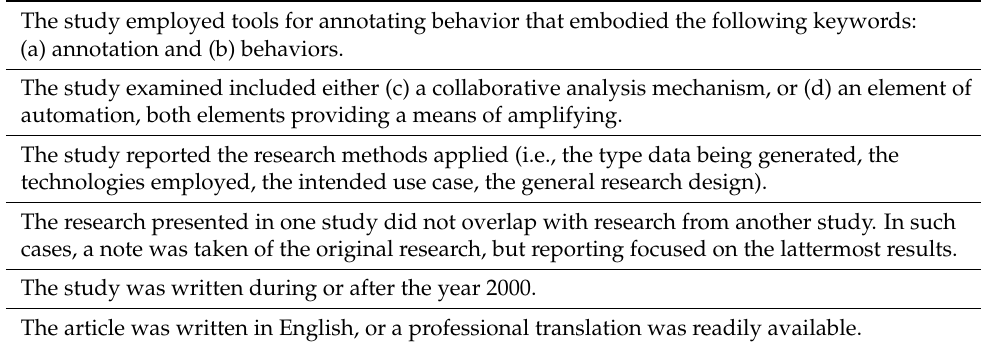
Table 3. Systematic Literature Review Selection